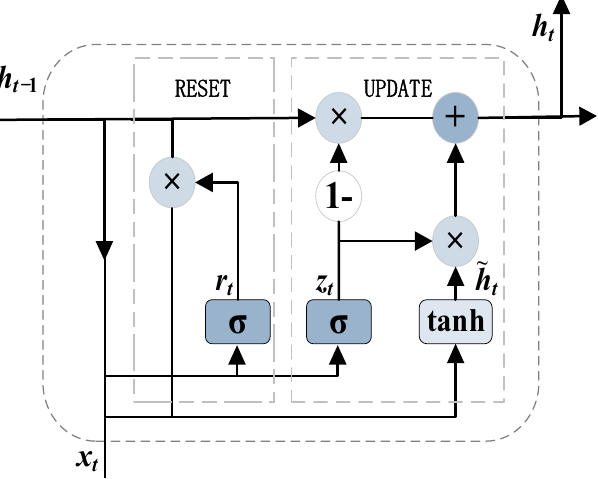
Figure 4. Gated Recurrent Unit.